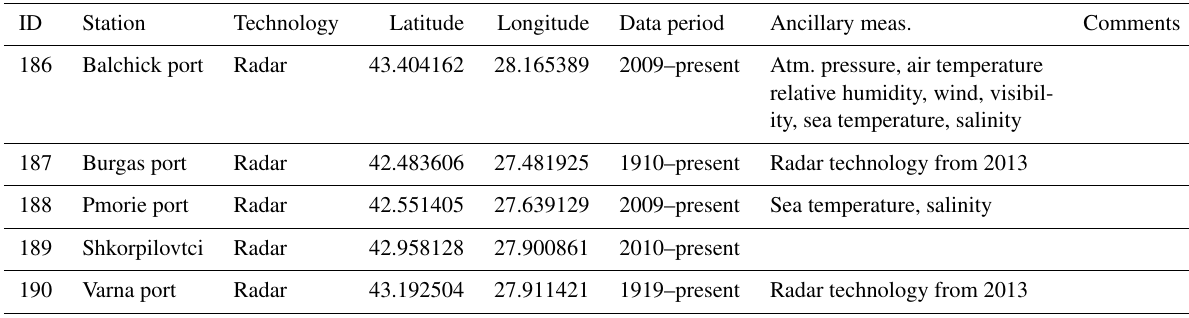
Table A18. Stations operated by the Bulgarian Coastal Sea Level Service (IO-BAS).